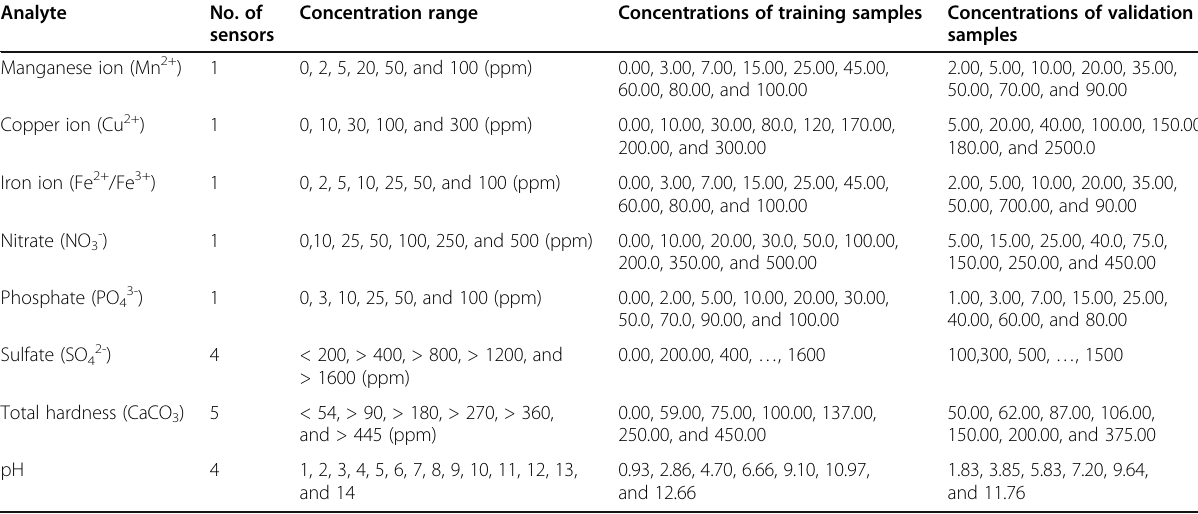
Table 1 Detail of colorimetric strips used in this investigation